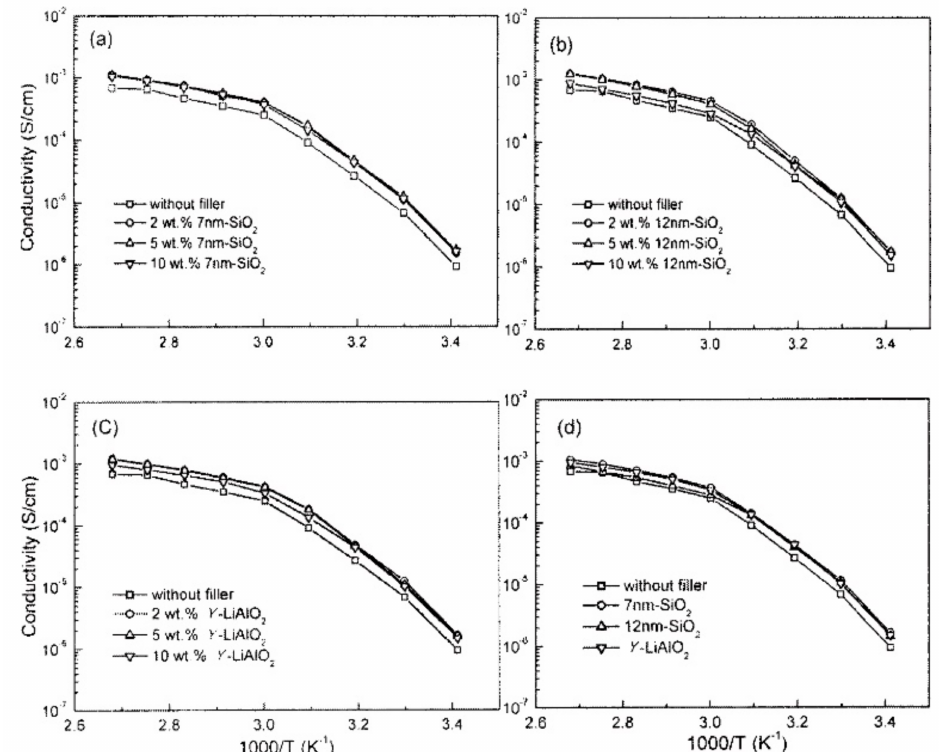
Figure 5. Arrhenius plots of the ionic conductivity of P(EO) 20 LiBETI + x ( x = 0, 2, 5, and 10) wt % filler ( a ) 7 nm SiO 2 , ( b ) 12 nm SiO 2 , ( c ) γ -LiAlO 2 and ( d ) P(EO) 20 LiBETI + 10 wt % filler polymer electrolyte sandwiched between Cu electrodes